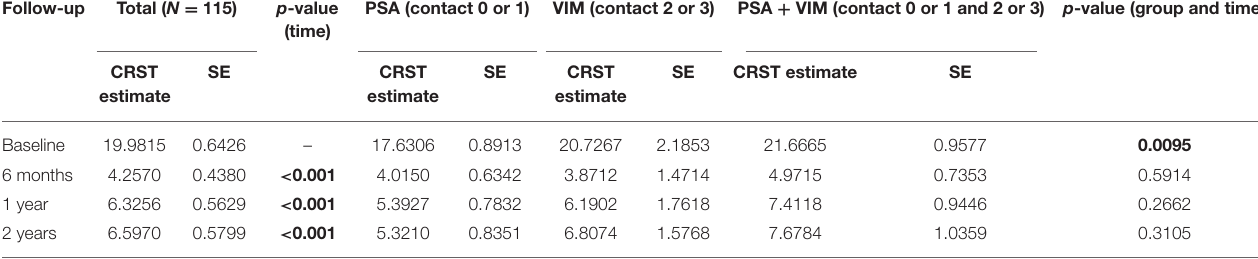
TABLE 3 | Clinical Rating Scale for Tremor (CRST) subscores over evaluation visits. Follow-up